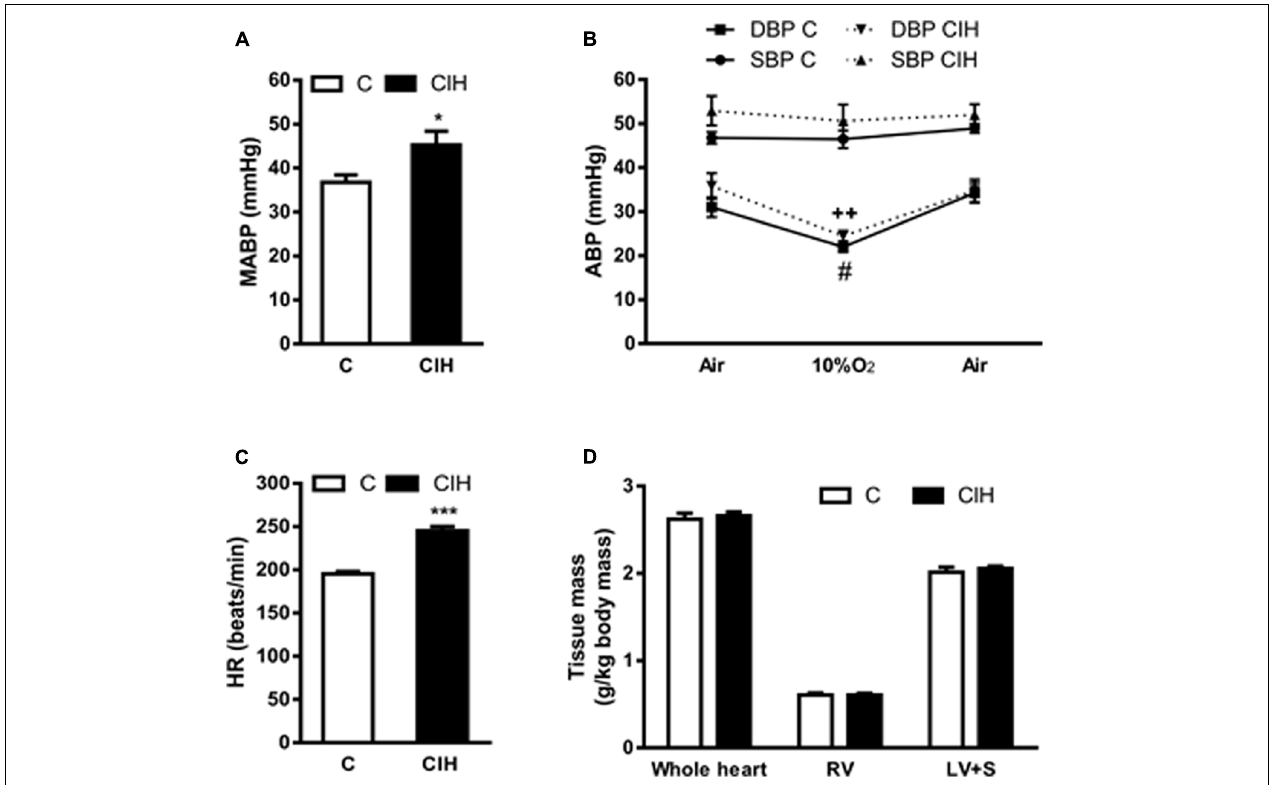
FIGURE 5 | Cardiovascular parameters from control and CIH guinea pigs. (A) Mean arterial blood pressure (MABP) in anesthetized control and CIH guinea pigs breathing air, measured by carotid artery catheterization. ∗ p < 0.05 CIH vs. C. unpaired t -test; Data are mean ± SEM ( n = 7); Unpaired t -test. (B) Systolic (SBP) and diastolic (DBP) blood pressure in basal (air), acute hypoxia (10% O 2 ) and recovery (air) from control and CIH guinea pigs. # p < 0.05, 10% O 2 vs. air C (DBP); ++ p < 0.01 10% O 2 vs. air CIH (DBP); Data are mean ± SEM ( n = 7–8); Two-way ANOVA with Tukey’s multiple comparison test. (C) Heart rate (beats per minute) measured in control and CIH guinea pigs breathing air. ∗∗∗ p < 0.001, CIH vs. C; Data are mean ± SEM ( n = 7); Unpaired t -test. (D) Weight of whole heart, right ventricle, and left ventricle plus septum, normalized by the body weight, expressed as g/kg body mass in control and CIH guinea pigs. Data are mean ± SEM ( n = 7); Two-way ANOVA with Sidak’s multiple comparison